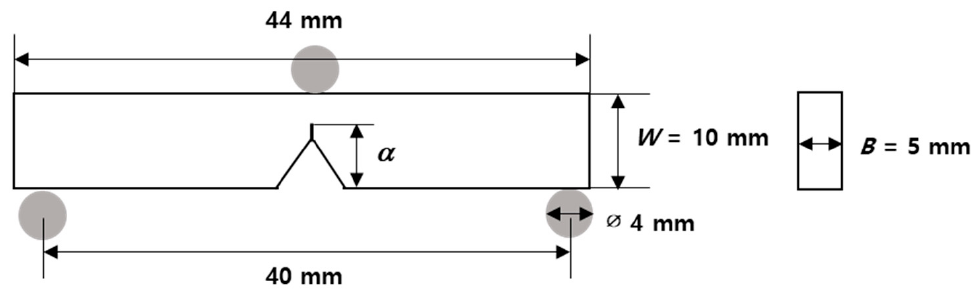
Figure 2. Dimension of the single-edged notch bending (SENB) specimen. The mode I fracture toughness ( K IC ) of silica-modified epoxy adhesives was calculated according to Equations (1) and (2) proposed by the ASTM D5045-99